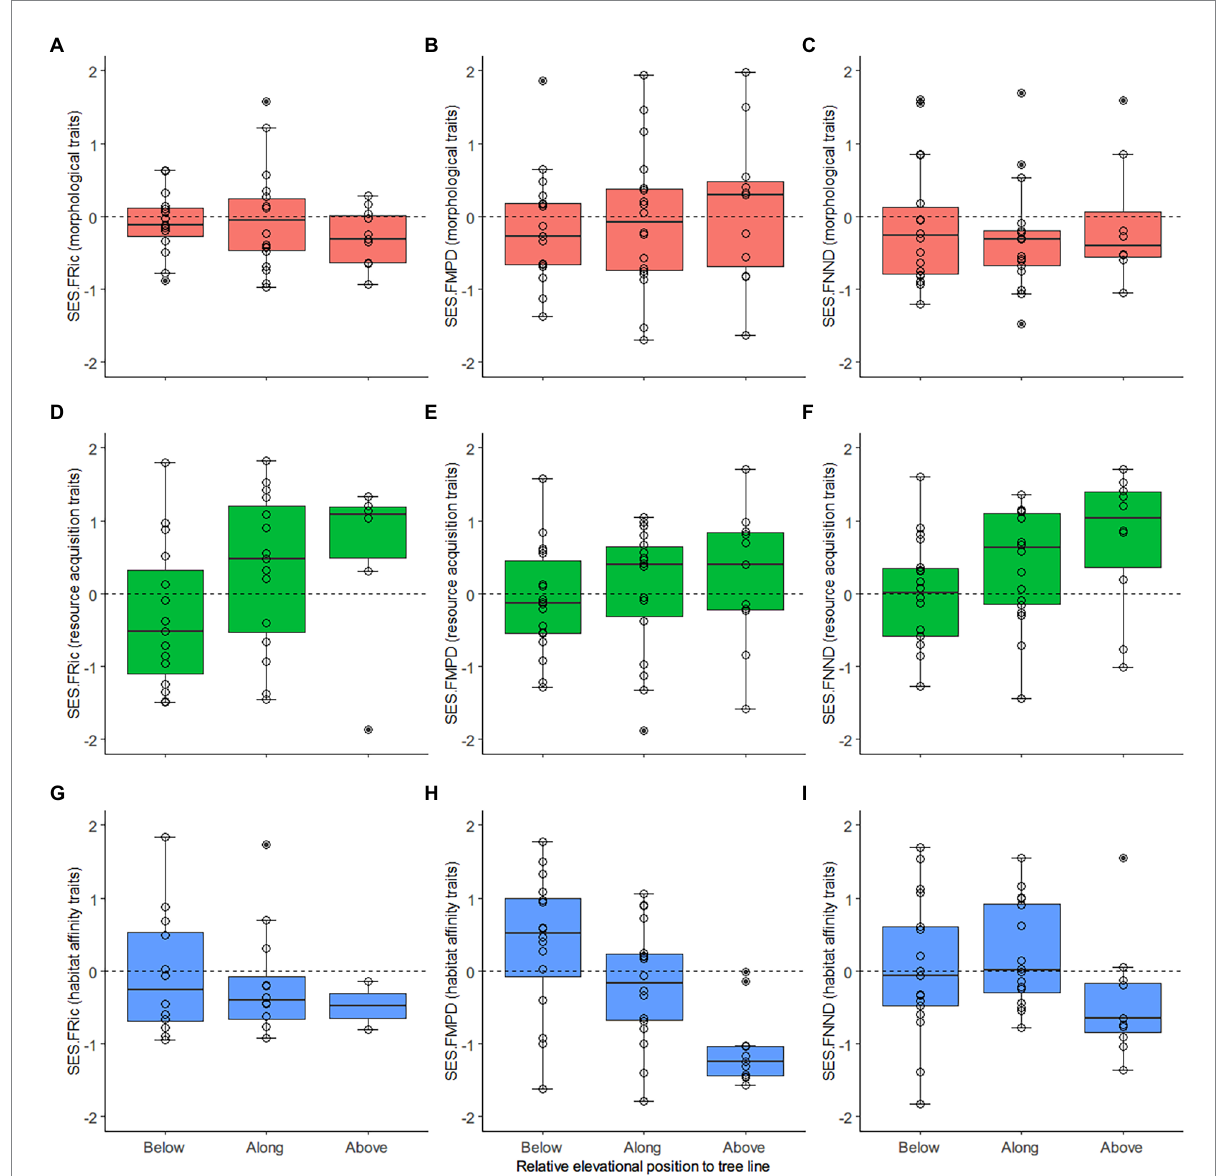
FIGURE 4 Distribution of the standardized effect size (SES) of the functional diversity metrics derived from different trait combinations. (A,D,G) Functional richness (FRic), measured as the minimum convex hull volume; (B,E,H) Average trait difference of all species pairs, functional mean pairwise distance (FMPD); (C,F,I) Average trait difference of every two most similar species, functional mean nearest neighbor distance (FNND). From top to bottom are the SESs derived from morphological (A-C) , resource acquisition (D-F) , and habitat affinity (G-I) traits. The X-axes mark transects from low (below the tree line) to high (above the tree line) elevation. The circles mark the SES values for the transects. In the boxplot, the horizontal solid line inside the box indicates the median, the box height represents values ranging from 25% to 75% percentile (middle 50% of scores), the upper and lower whiskers represent scores outside the middle 50%, and the dots mark the